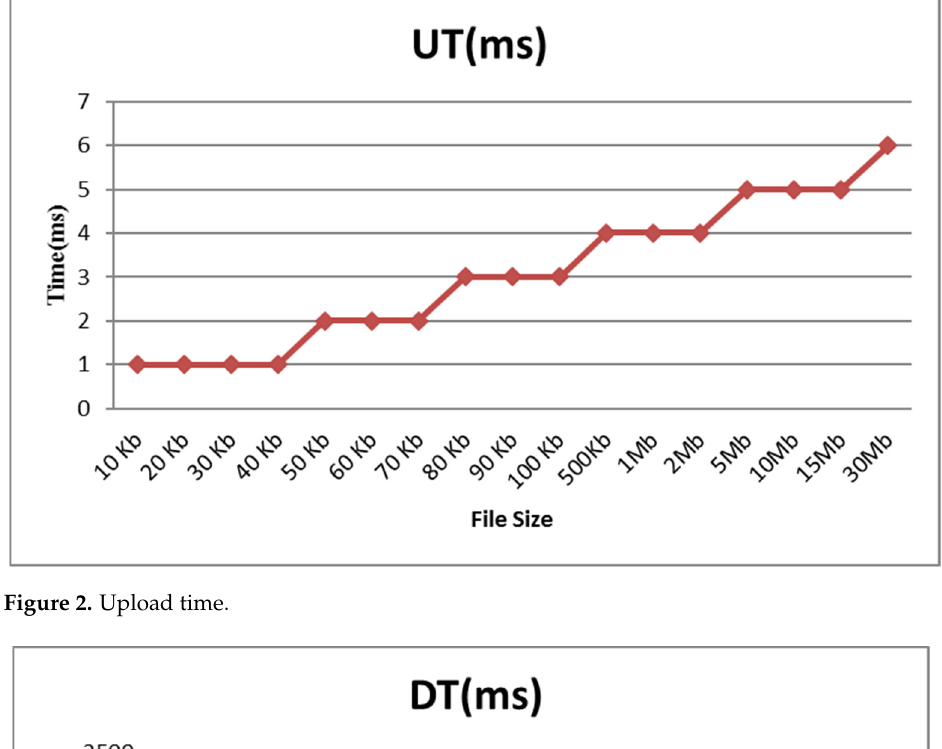
Figure 2. Upload time.